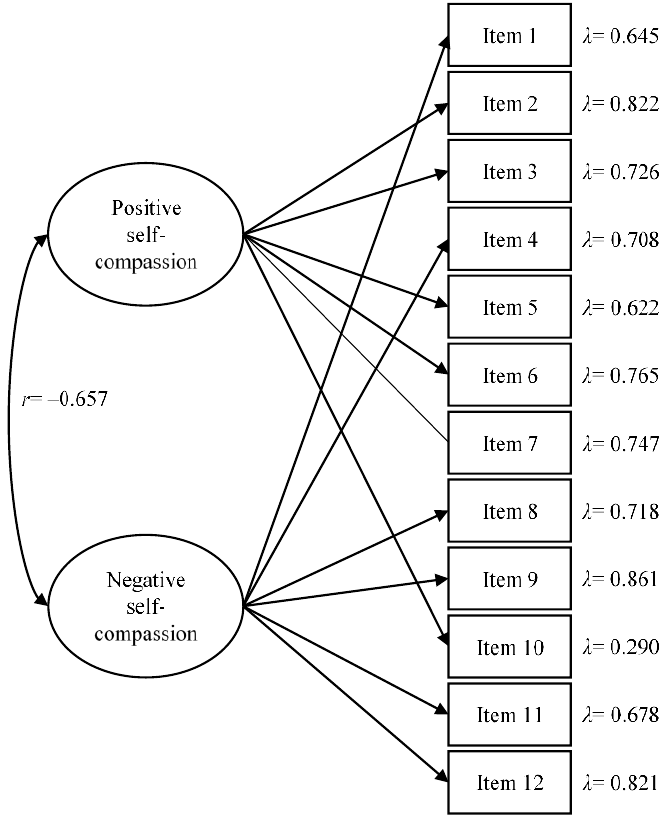
Figure 2. Analytical fit of the two-factor solution of the Self-Compassion Scale—Short Form (SCS-SF). For the sake of clarity, standardized values are offered. All factor loadings were statistically significant ( p < 0.001).